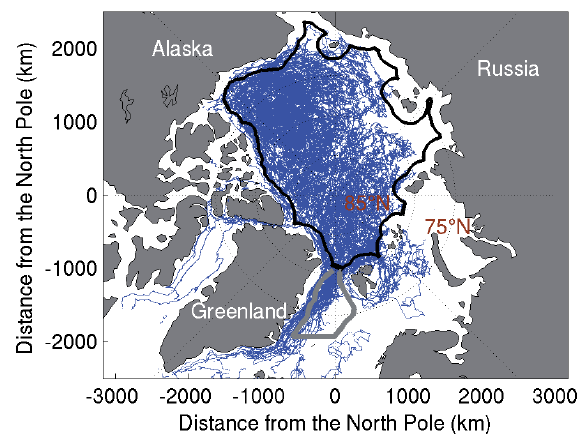
Fig. 1. Map of the Arctic basin showing the buoy trajectories of the IABP dataset. The positions are sampled every 3h from January 1979 to December 2008 and plotted following a stereographic projection centered on the North Pole. The Laptev sea is poorly covered by this dataset. The thick solid black and grey lines define the Central Arctic basin and the Fram strait region, respectively.